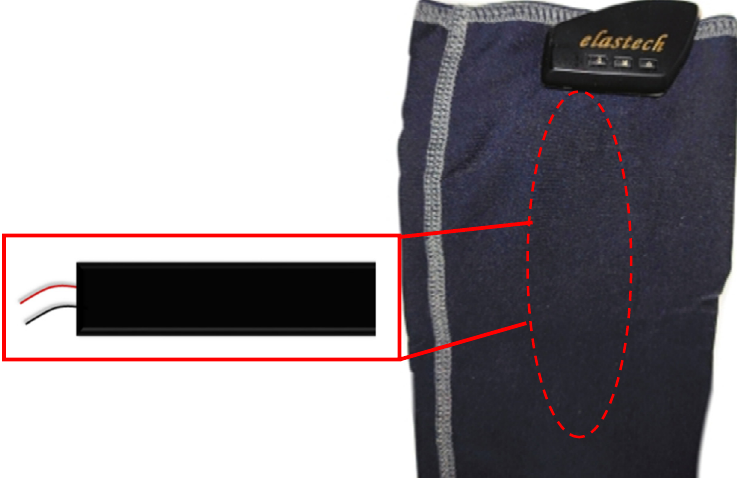
Figure 6. Diagram of the flexible sensor.